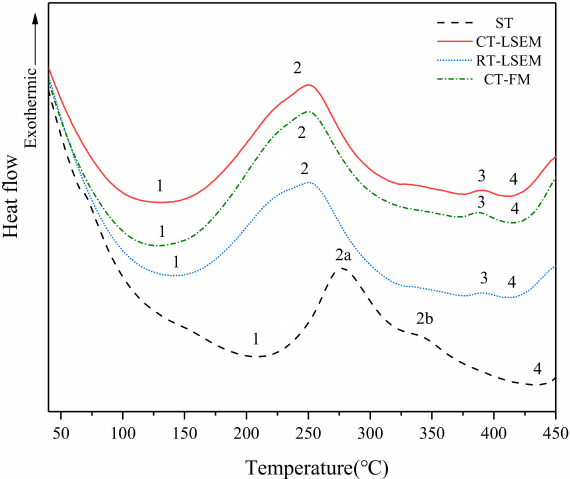
Figure 5. DSC scans of ST, RT and CT LSEM Al 7075 alloy samples with a heating rate of 30 ◦ C / min at Vc = 5.4 m /